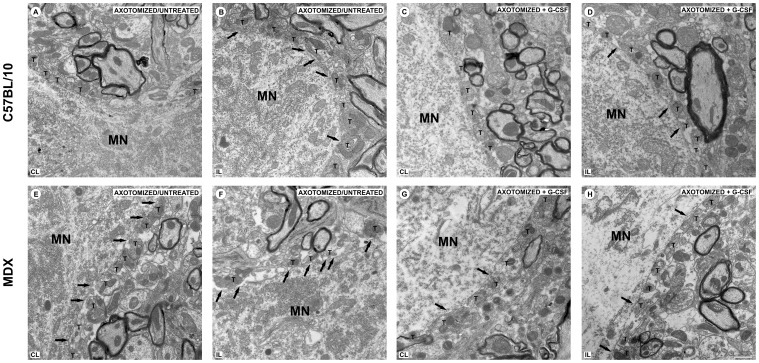
Surface ultrastructure of alpha-motoneurons one week after axotomy.(A–H) Transmission electron microscopy images. (A) synaptic covering of neuron of the C57BL/10 contralateral/untreated group. (B) synaptic covering of neuron of the C57BL/10 ipsilateral/untreated group. The astrocytic retractions and projections in this group express a significant increase compared with the contralateral side of the same strain one week after injury. (C) synaptic covering of neuron of the C57BL/10 contralateral+G-CSF group. (D) synaptic covering of neuron of the C57BL/10 ipsilateral+G-CSF group. (E) synaptic covering of neuron of the MDX contralateral/untreated group. (F) synaptic covering of neuron of the MDX ipsilateral/untreated group. (G) synaptic covering of neuron of the MDX contralateral+ G-CSF group. (H) synaptic covering of neuron of the MDX ipsilateral+ G-CSF group. Note the retraction and gliosis processes exacerbated in the untreated groups. In the groups treated with G-CSF, the retraction processes must be smaller. In all experiments: n = 5. In A–H, magnification, X4800 (scale bar, 1 µm). In B–H, the arrows indicate that the alpha-motoneurons are partially detached, with a reduced area of apposition. In A–H, T indicates the presynaptic terminals and MN indicates alpha-motoneurons cell body.